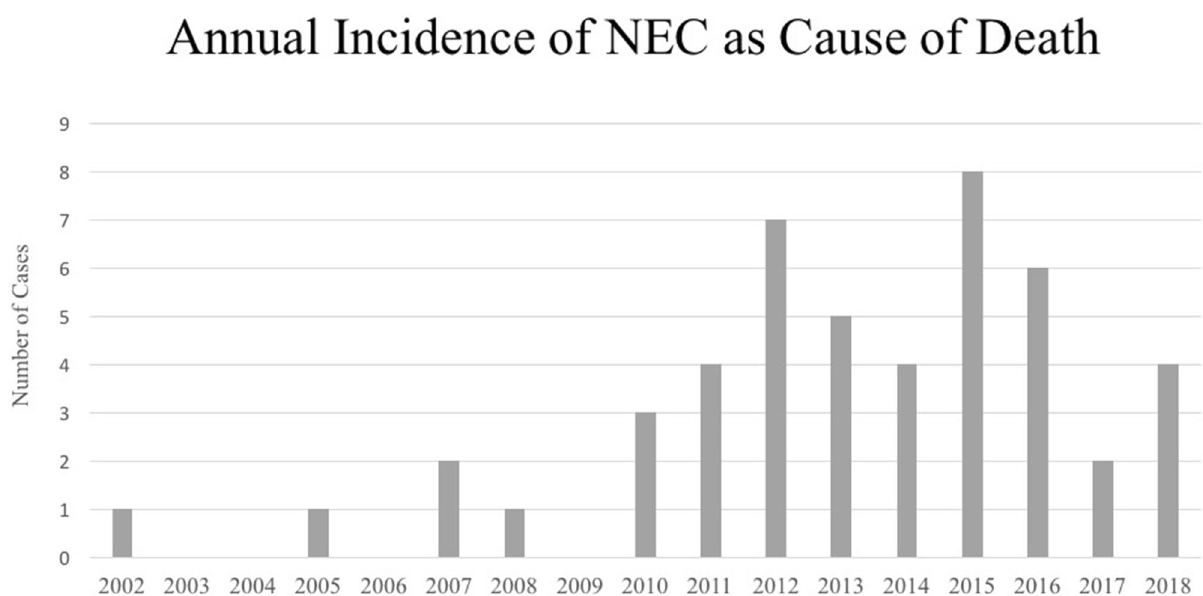
Figure 1. Annual incidence of NEC as cause of death from 2002 to